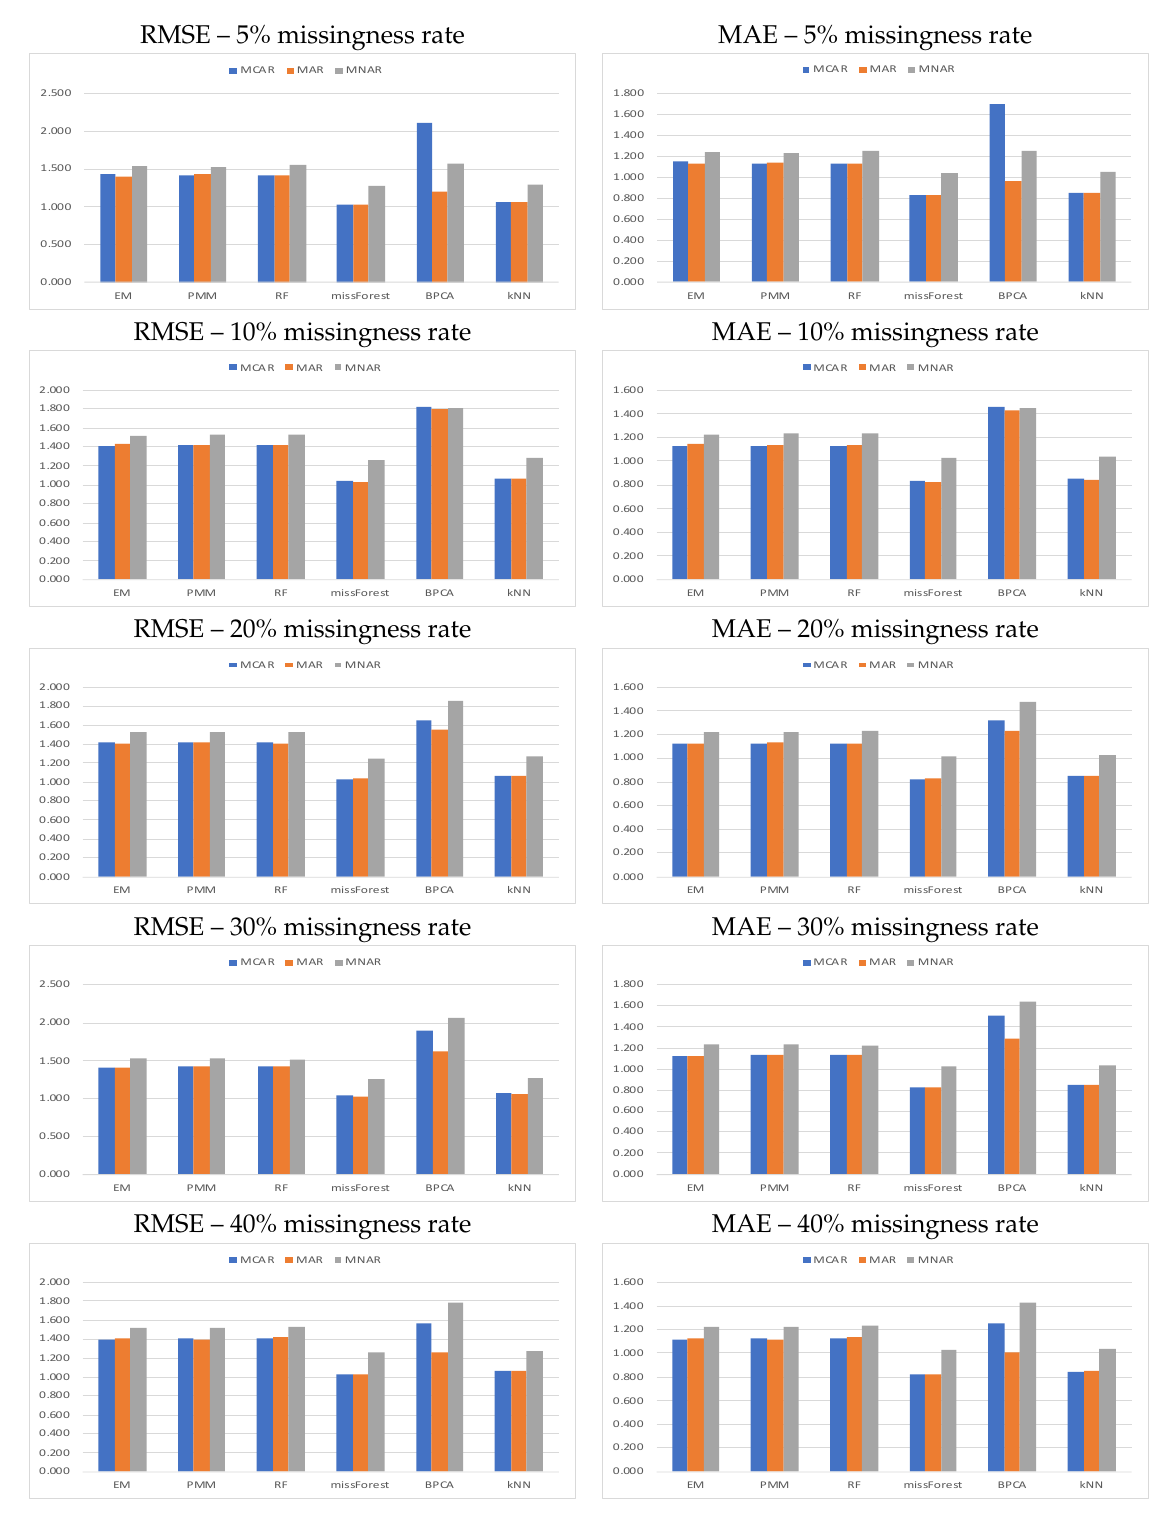
Figure A.4. Mean RMSE and MAE results for the KEPA data, in order to estimate missing values for SO 2 , NO 2 , CO , and O 3 after eliminating PM 10 due to a high level of missing values. Results are shown for MCAR (left), MAR (middle), and MNAR (right) data.